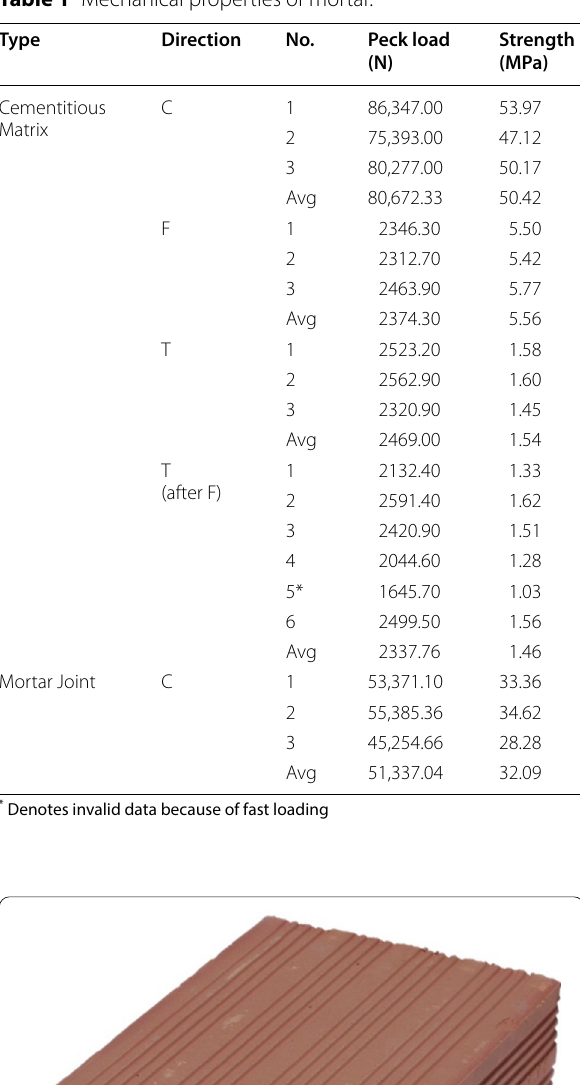
Table 1 Mechanical properties of mortar.